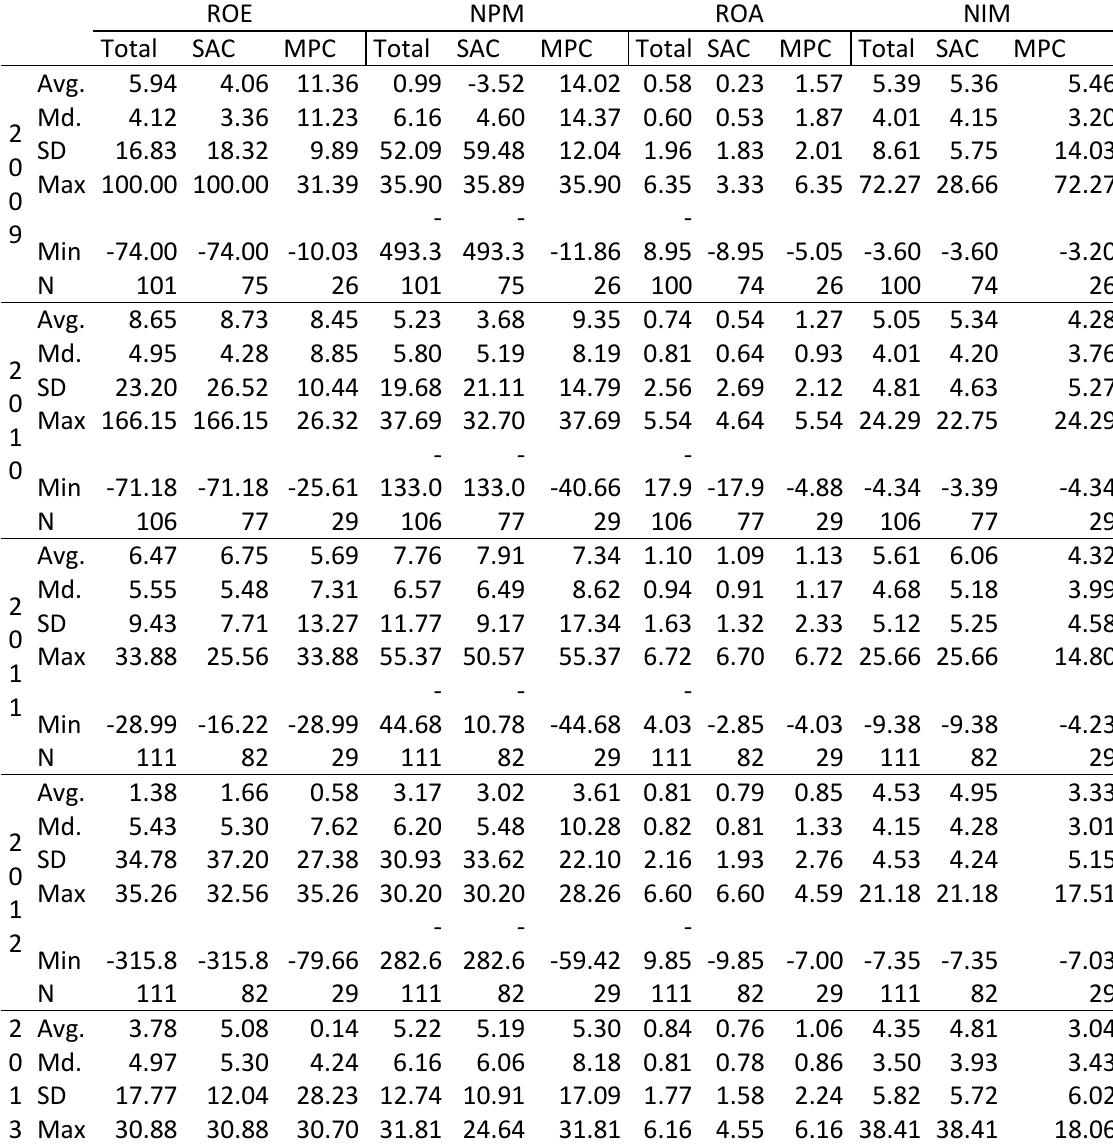
Table 2: Profitability Ratios of 2009-13 (in percent) ROE NPM ROA Total Md. Max 100.00